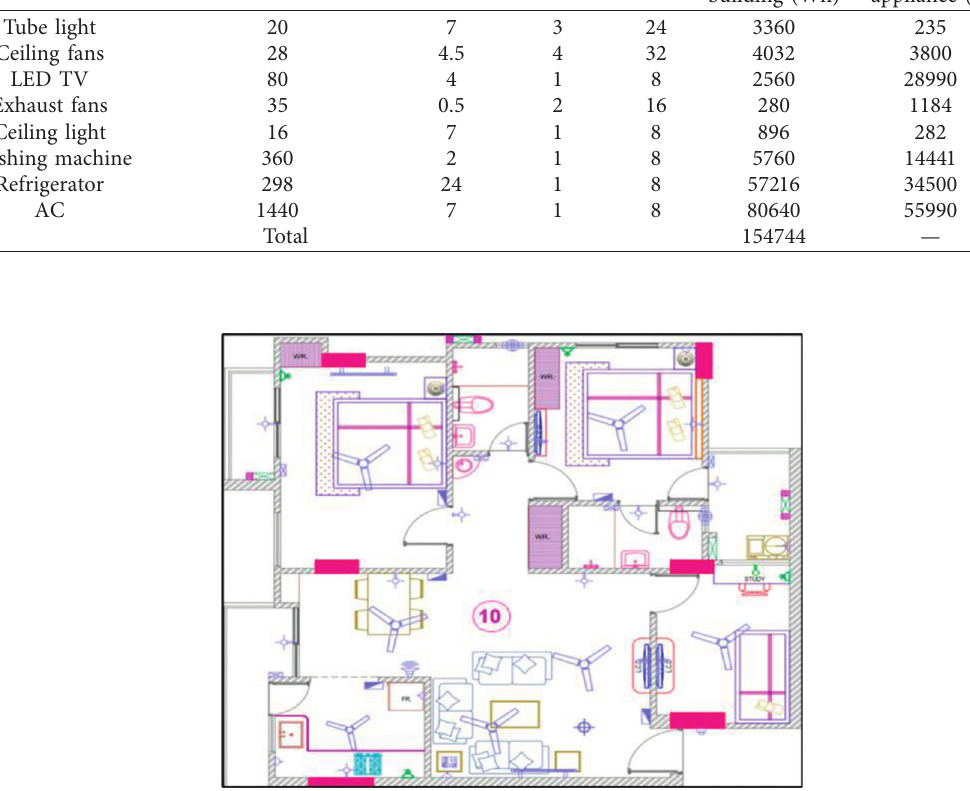
Figure 5: 2BHK flat layout.